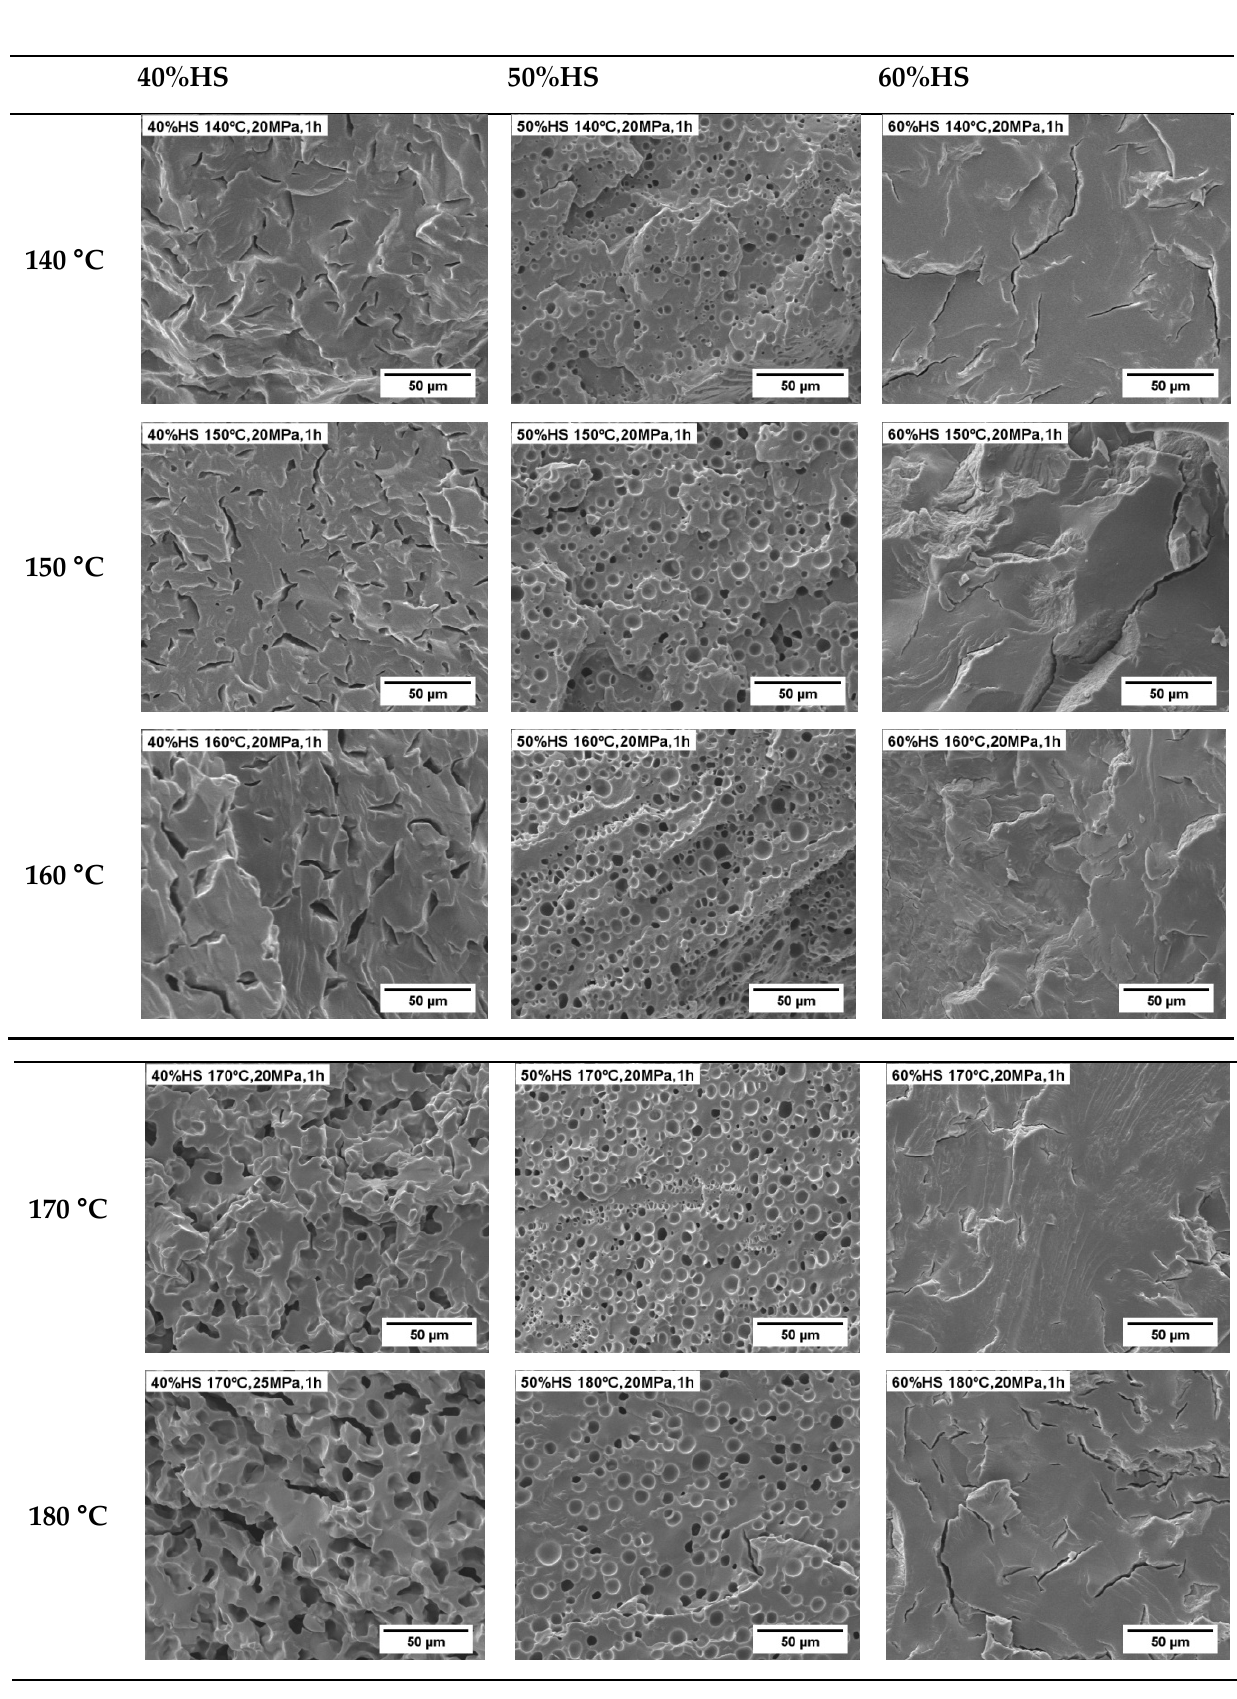
Figure 5. SEM micrographs of TPU with different HS% foamed by a one-step process between 140 and 180 ° C, 20 MPa, and 1 h.